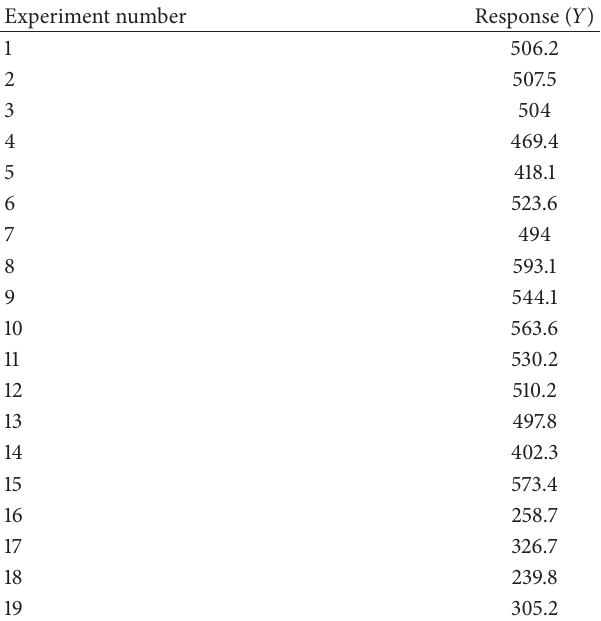
Table 3: Experimental data obtained for the